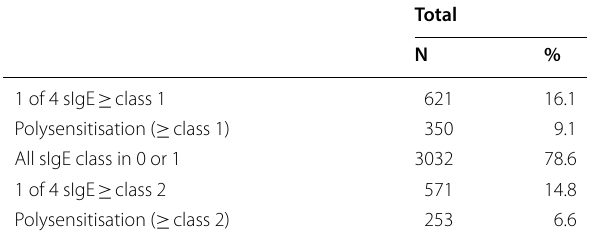
Table 1 Characteristics of the study group (% in columns)